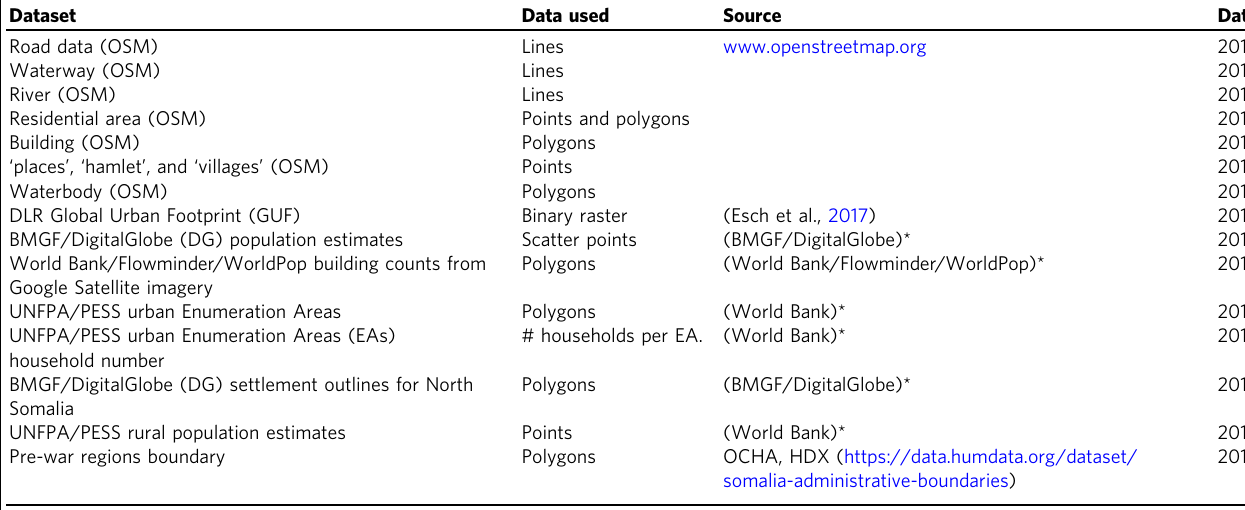
Table 1 Data used for somalia enumeration